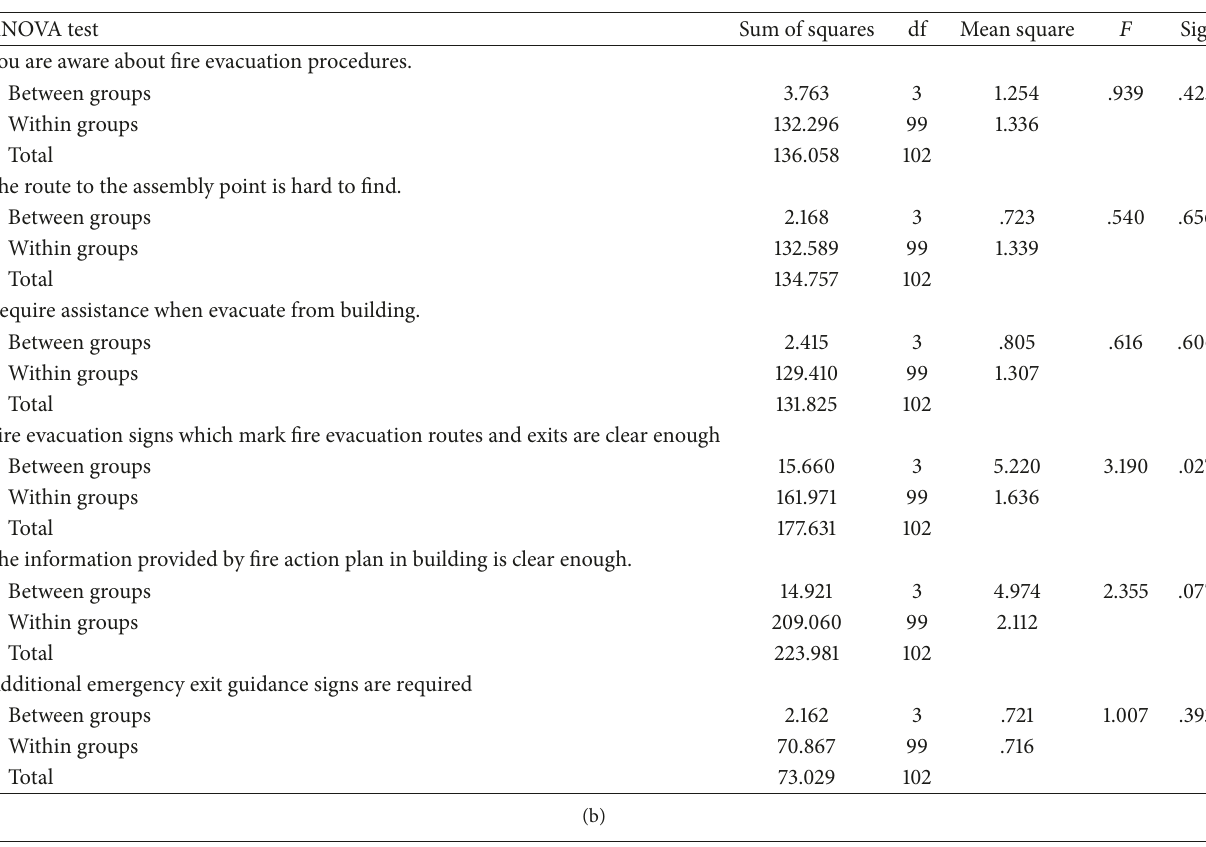
Table 6: ANOVA and post hoc tests regarding respondents’ age.